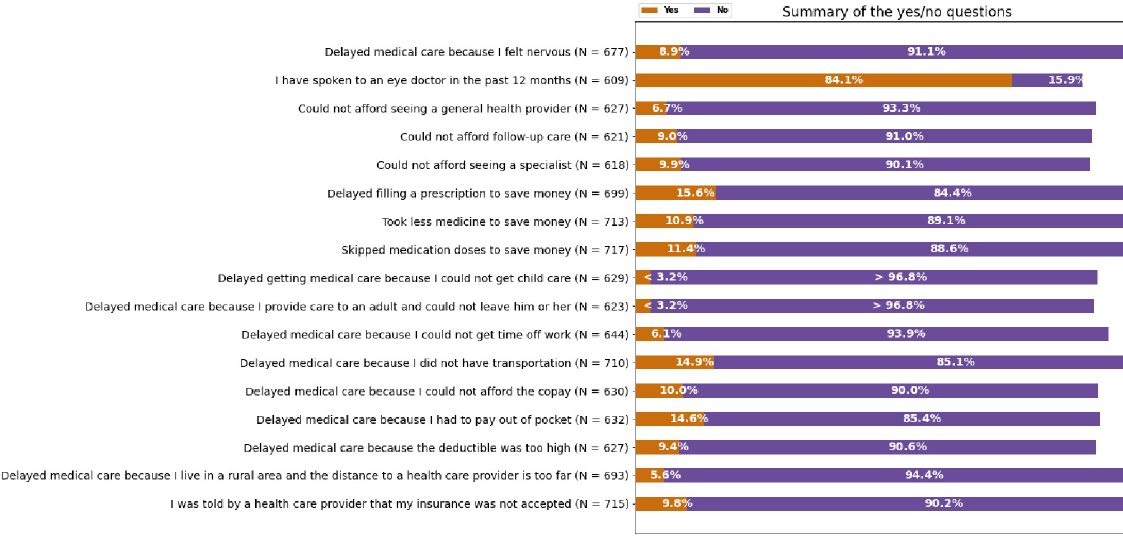
Fig 1. Distribution of responses to questions regarding healthcare access and utilization among patients with diabetic retinopathy in the NIH All of Us research program.